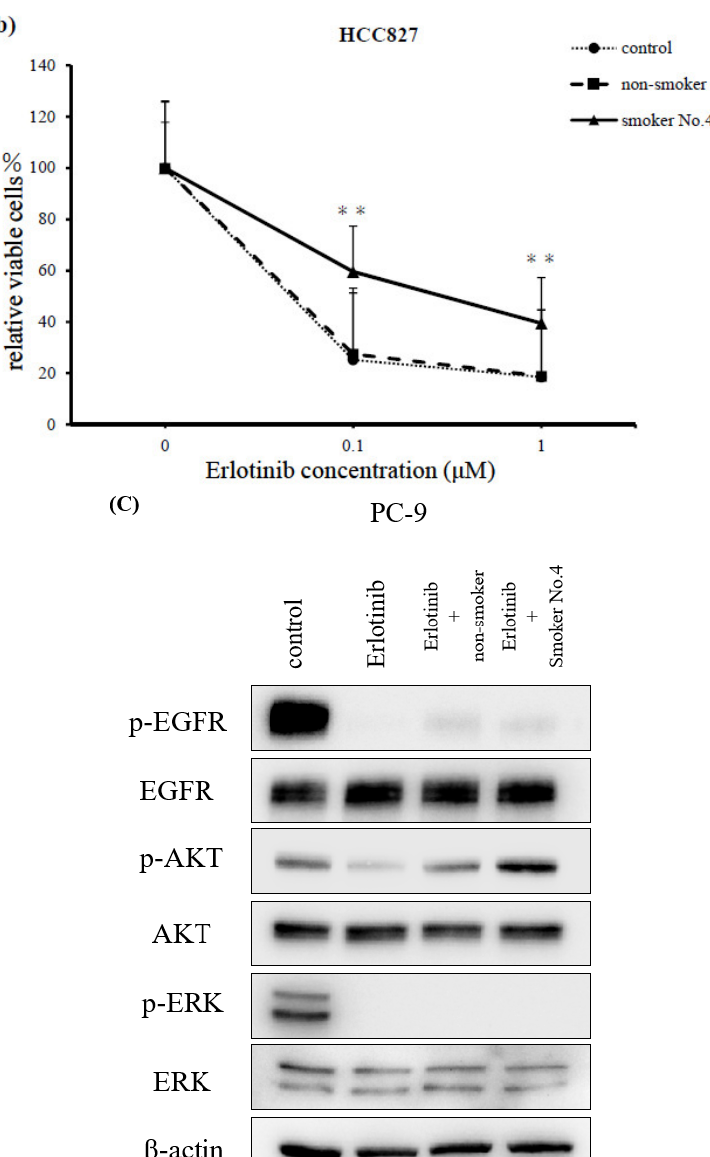
Figure 2. Comparisons of ( a ) PC9 and ( b ) HCC827 cell lines cultured for 72 h with various concentrations of erlotinib (0, 0.1, and 1 µ M), and serum from the non-smoker and smoker No. 4. Serum from the smokers demonstrated significant resistance to erlotinib treatment at all concentrations in both cell lines, compared with serum from the non-smoker (at 1 µ M erlotinib in the PC9 cell, p = 0.0018; for all other comparisons, p < 0.001). Cell survival was assessed using a cell counting kit (CCK)-F. Results are means ± SEM of four independent experiments. ( c ) Immunoblot analysis of PC9 cells incubated with erlotinib (1 µ M), and serum from the non-smoker or smoker No. 4 for 1 h. The combination of erlotinib with serum from the smoker elevated the protein levels of the phosphorylated AKT (Ser 473) considerably. AKT phosphorylation was inhibited by erlotinib and serum from the non-smoker. Erlotinib inhibited the phosphorylation of EGFR and ERK, independent of serum addition. The control is untreated cells.